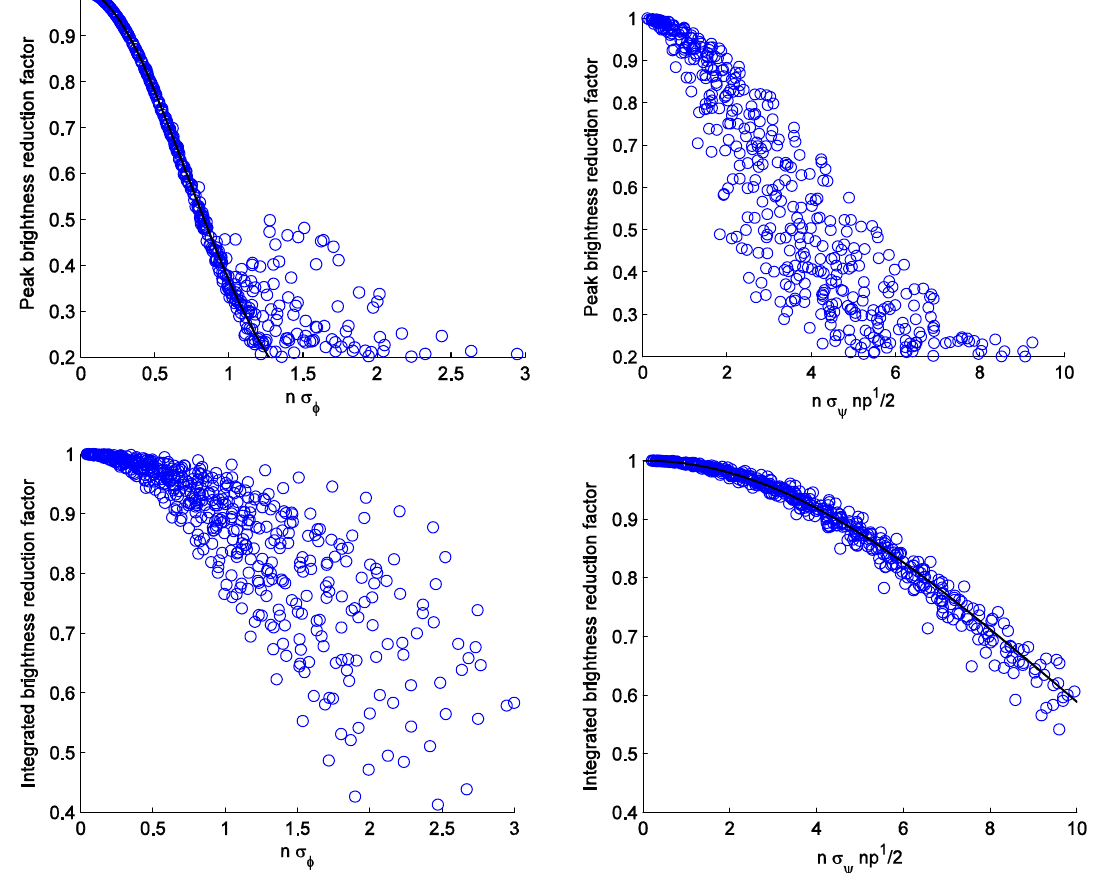
FIG. 12. Reduction factors in single-electron peak (upper plots) and integrated (lower plots) brightness, as functions of rms phase error (left-hand plots) and rms local phase error (right-hand plots) in radians, for random-walk errors with a range of values of (cid:1) c and n , and odd harmonics 1–21. The solid lines are upper-left—Eq. (1); lower-right—Eq. p